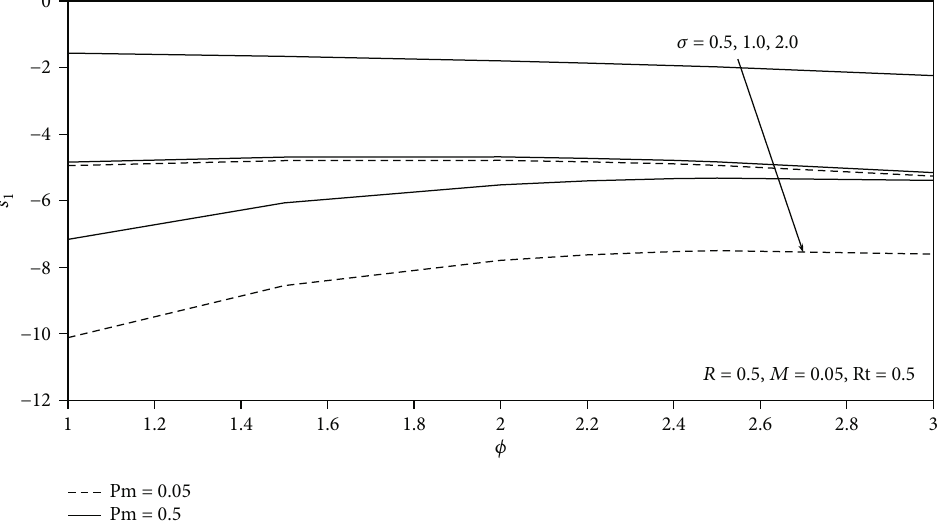
ϕ for di ff erent values of Pm and σ 1 Þ versus